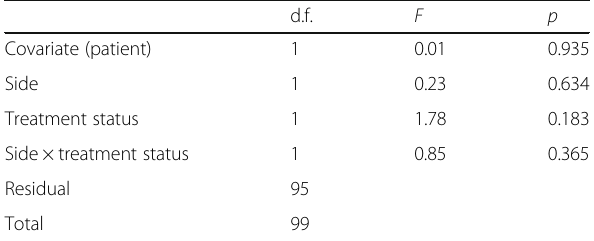
Table 2 Alveolar bone height measurements (mm). Descriptive statistics for each study parameter Dependent variable